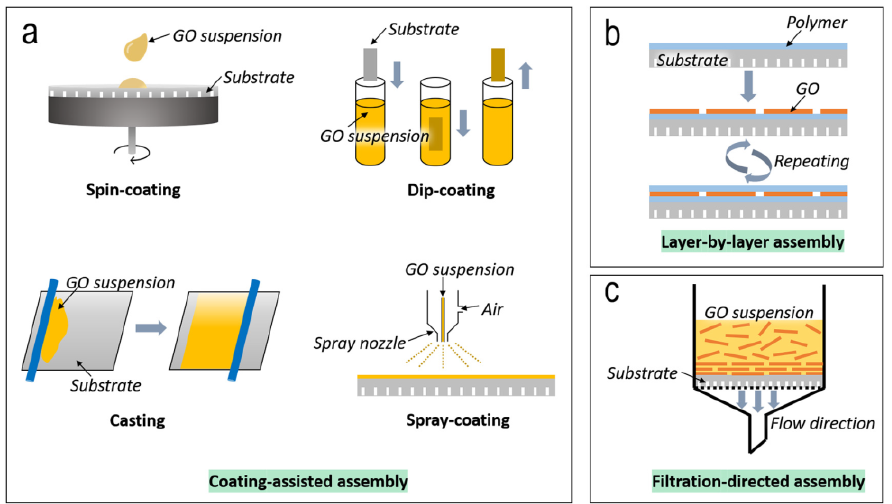
Figure 2. Commonly used manufacturing approaches of membranes based on graphene: ( a ) coating-assisted, ( b ) LbL and ( c ) filtration-based assembly. Reprinted with permission from Ref. [88].